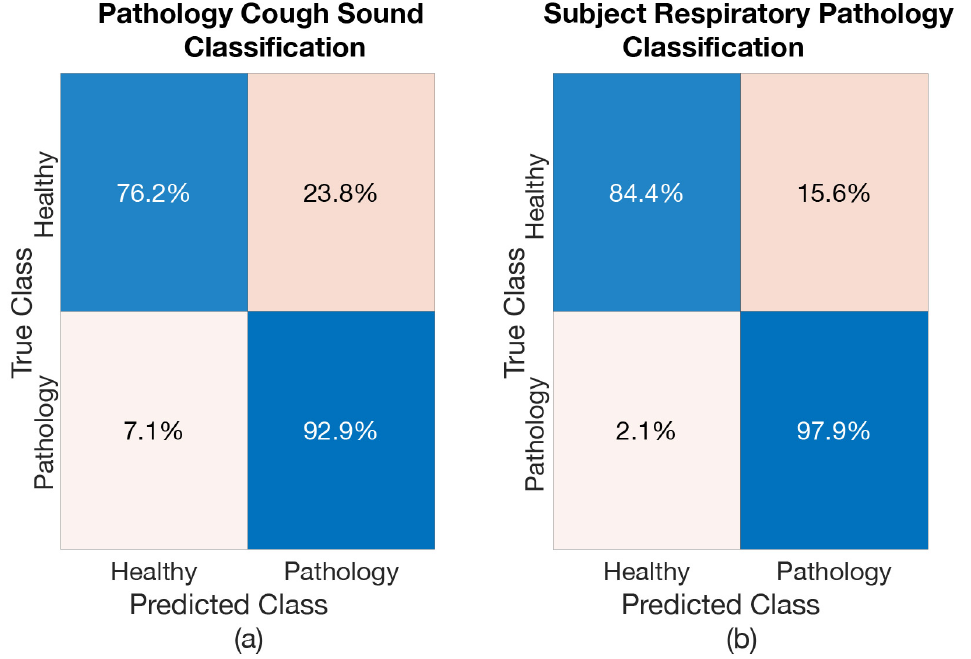
Figure 6. Confusion Matrix of Model Healthy vs. pathology : ( a ) when classifying coughs, ( b ) when classifying subject for respiratory pathology.